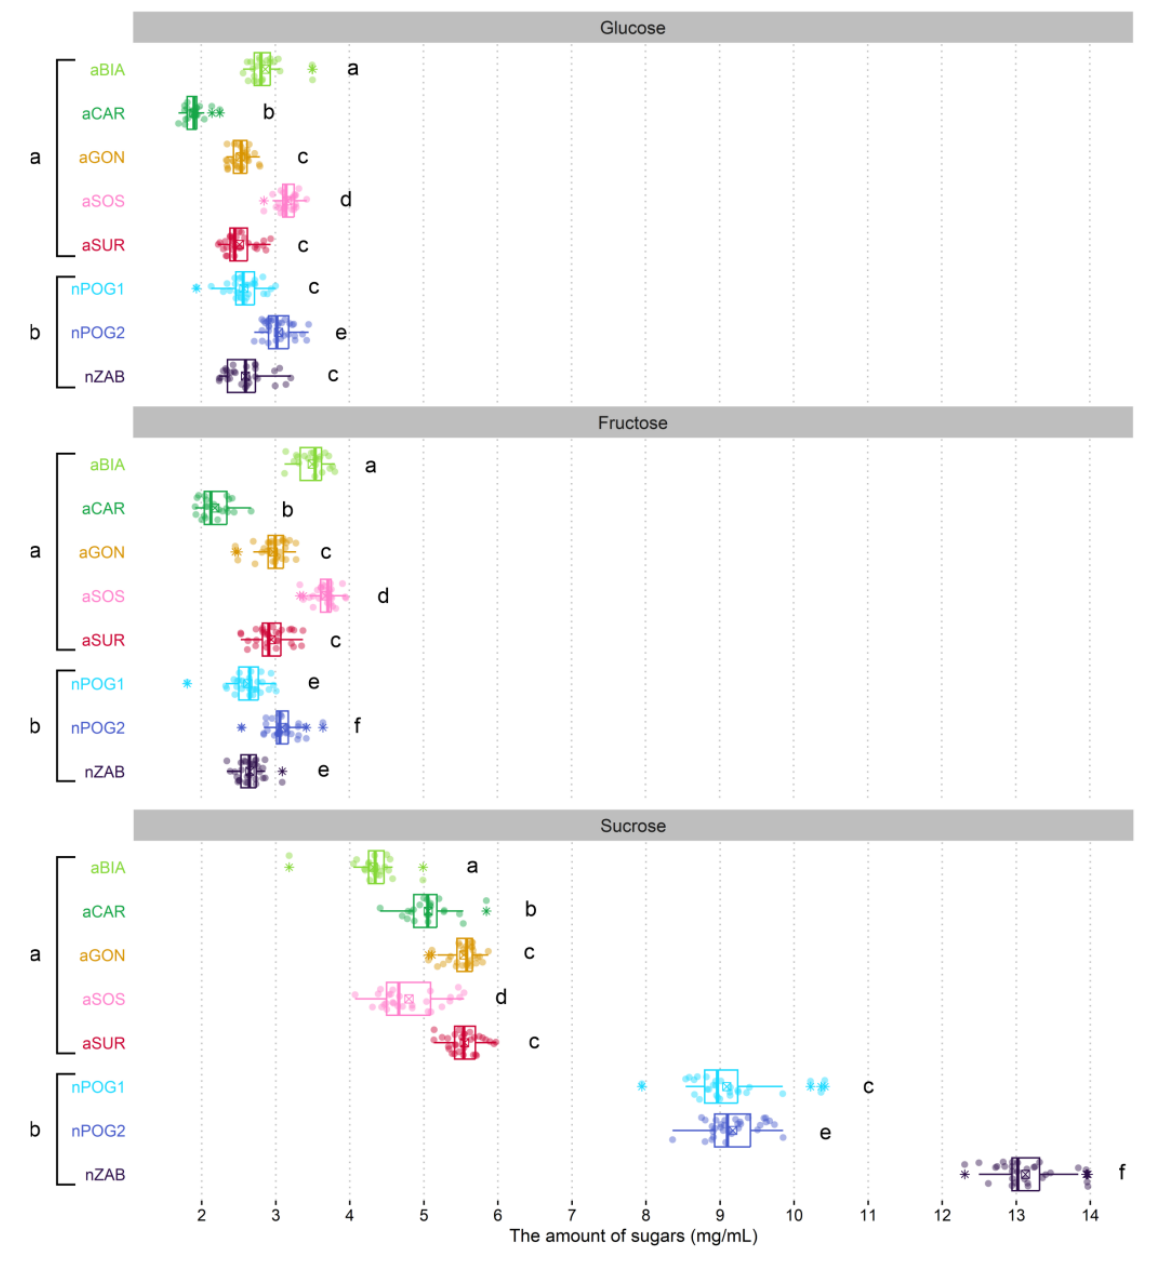
Figure 2. Boxplots of sugar amount for anthropogenic (aBIA, aCAR, aGON, aSOS, and aSUR) and natural (nPOG1, nPOG2, and nZAB) populations of Epipactis helleborine . The colored dots are individual samples. The square crossed shows the mean. The lower and upper hinges correspond to the lower (Q 1 ) and upper (Q 3 ) quartiles. Thus, the length of the box shows the interquartile range (IQR). The thicker line inside the boxes corresponds to the median. The lower whisker extends from the hinge to the smallest value at most Q 1 − 1.5 × IQR of the hinge. The upper whisker extends from the hinge to the highest value no further than Q 3 + 1.5 × IQR. Data beyond the end of the whiskers, indicated with an asterisk symbol, are outliers. Different lowercase letters indicate statistically significant differences according to the pairwise Wilcoxon rank sum test with the Benjamini–Hochberg adjustment ( p < 0.05). Additional comparisons between natural and anthropogenic populations on the left/right sides are shown. Table 3. The percentage content of sugars and their ratios in Epipactis helleborine nectar. Data repre- sent the mean (x) ± standard error (SE), lower quartile (Q 1 ), median (Q 2 ), upper quartile (Q 3 ), inter- quartile range (IQR), and biological replicate (n). Different letters indicate statistically significant differences according to the pairwise Wilcoxon rank sum test with the Benjamini – Hochberg adjust- ment ( p < 0.05). Sugars